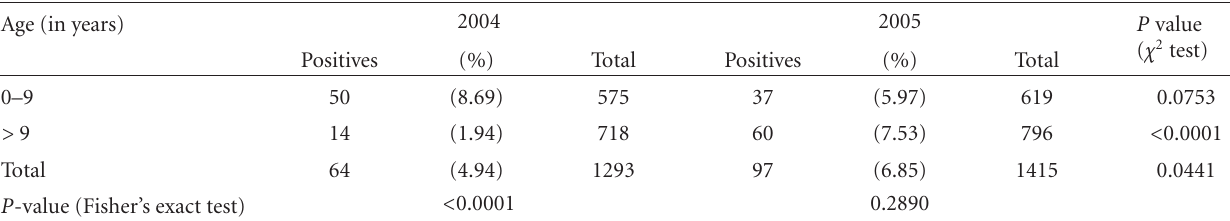
Table 4: Relationship between the age group and plasmodic index.